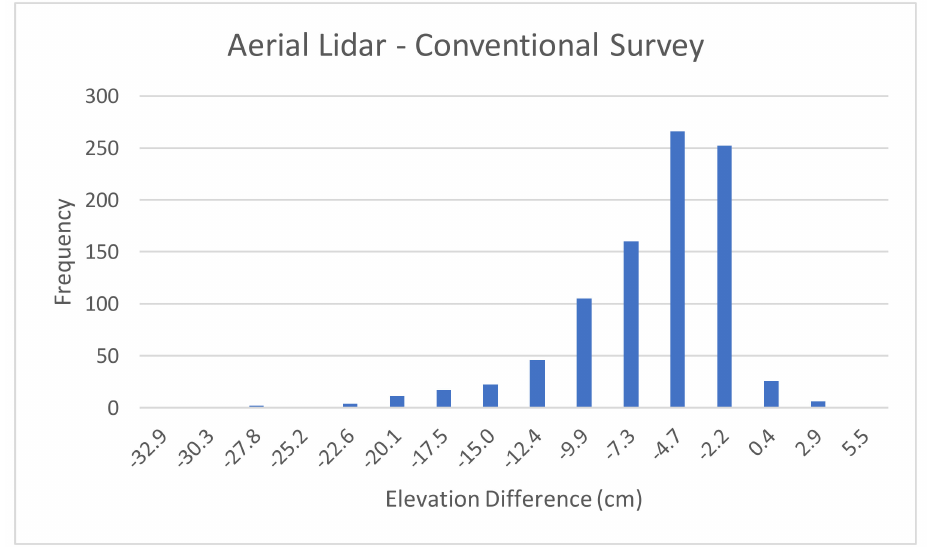
Figure 5. Elevation Di ff erence Between Aerial Lidar and Conventional Survey.